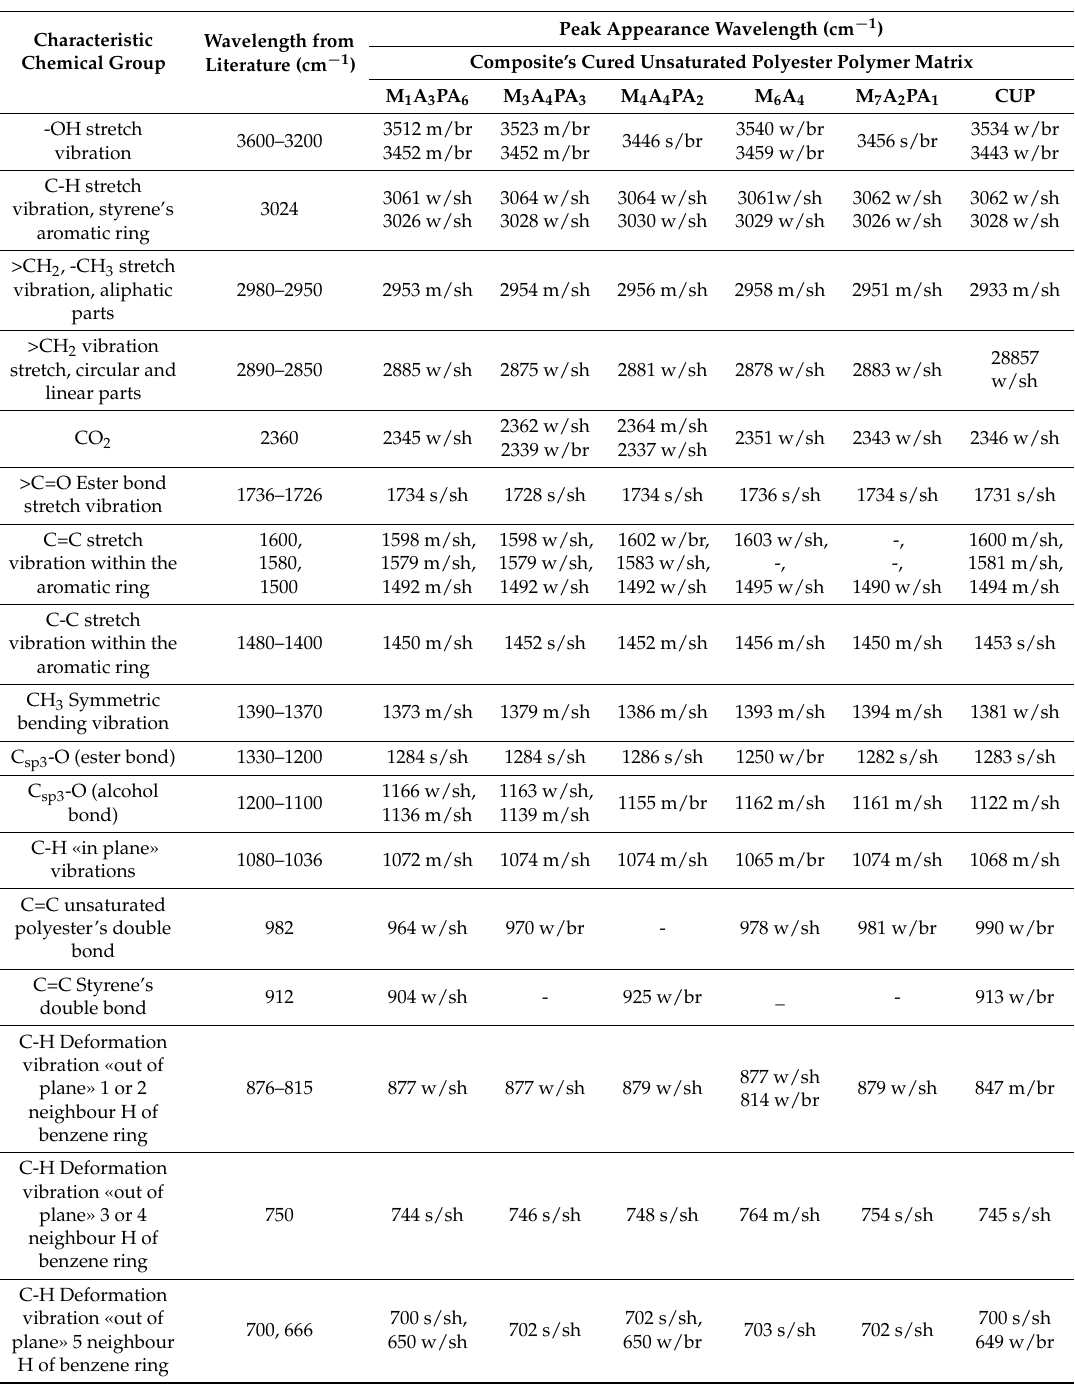
Table 7. FT-IR spectra characteristic peaks from unsaturated polyesters (M 1 A 3 PA 6 , M 3 A 4 PA 3